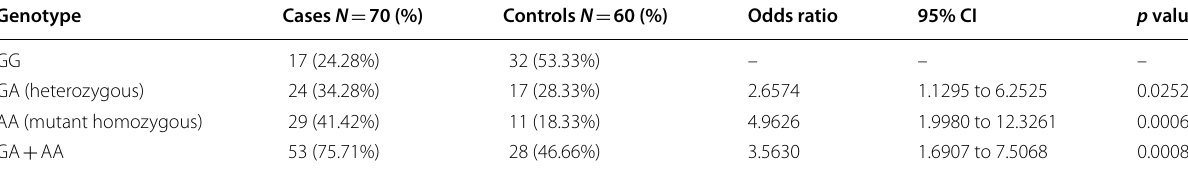
Table 4 SMAD4 Gene rs10502913 polymorphisms in breast cancer patients and control subjects Genotype Cases N